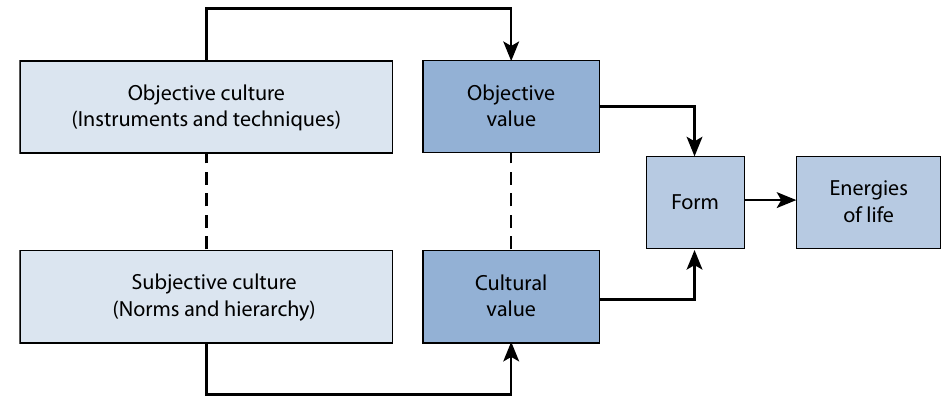
fig. 2. from culture to life process